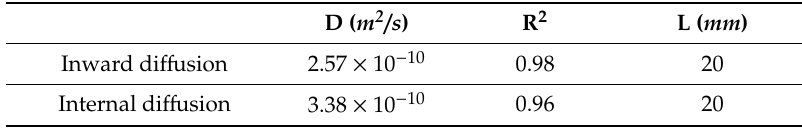
Table 7. Fitting results of inward diffusion D and internal diffusion D.